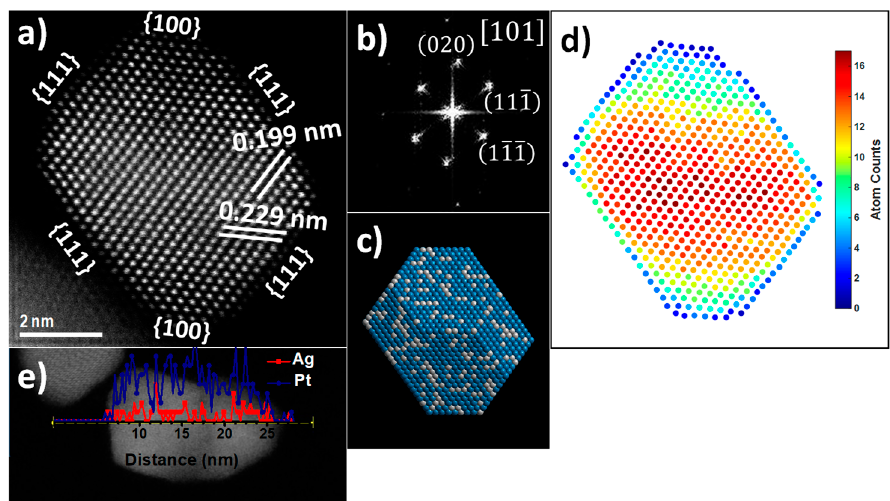
Figure 3. ( a ) HAADF-STEM image of AgPt (1:3) BNP along the [101] zone axis, ( b ) FFT pattern, ( c ) truncated octahedron model along the same direction, ( d ) atom counts, and ( e ) Ag and Pt elemental profiles along the line across the BNPs.